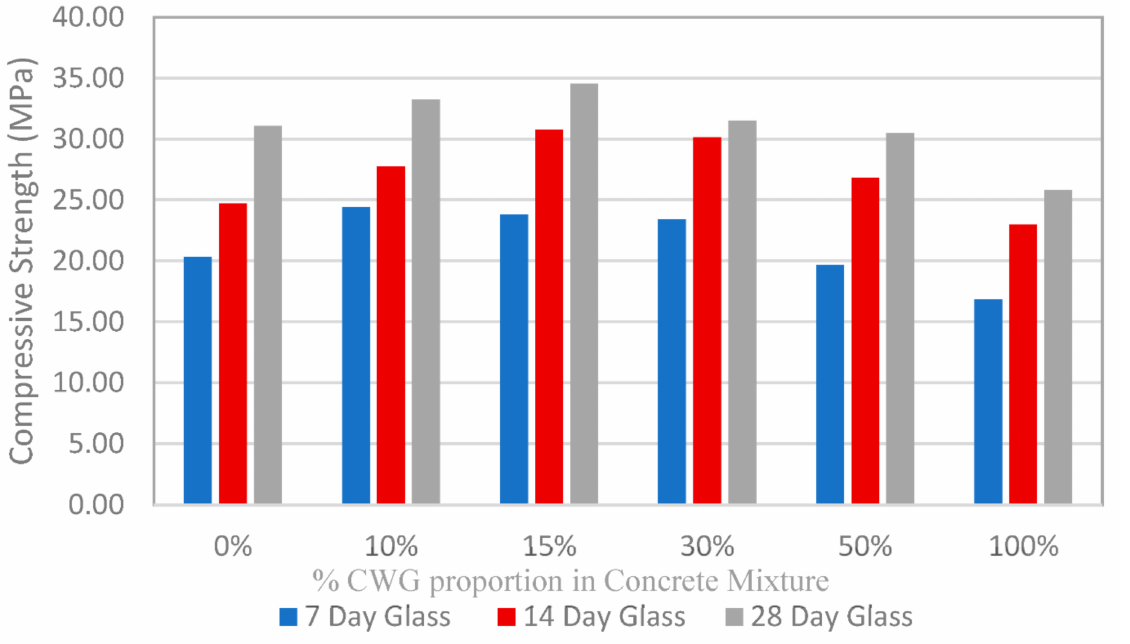
Figure 12. Effect of glass content on compressive strength concrete